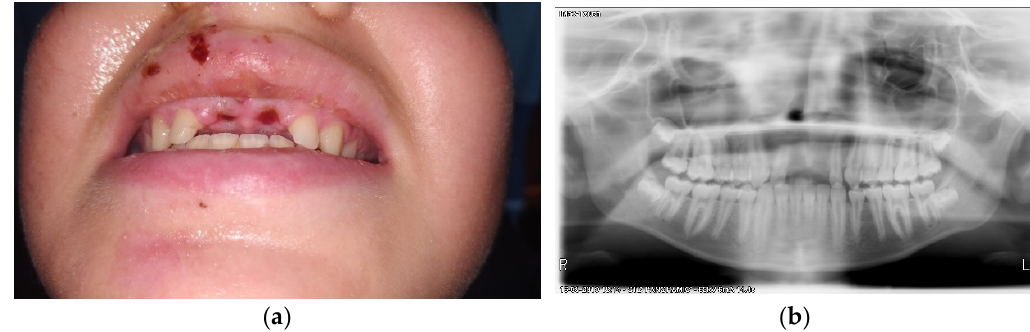
Figure 1. ( a ) Orofacial trauma with upper central incisors missing; ( b ) Panoramic X-ray confirming avulsion of teeth 11 and 21.